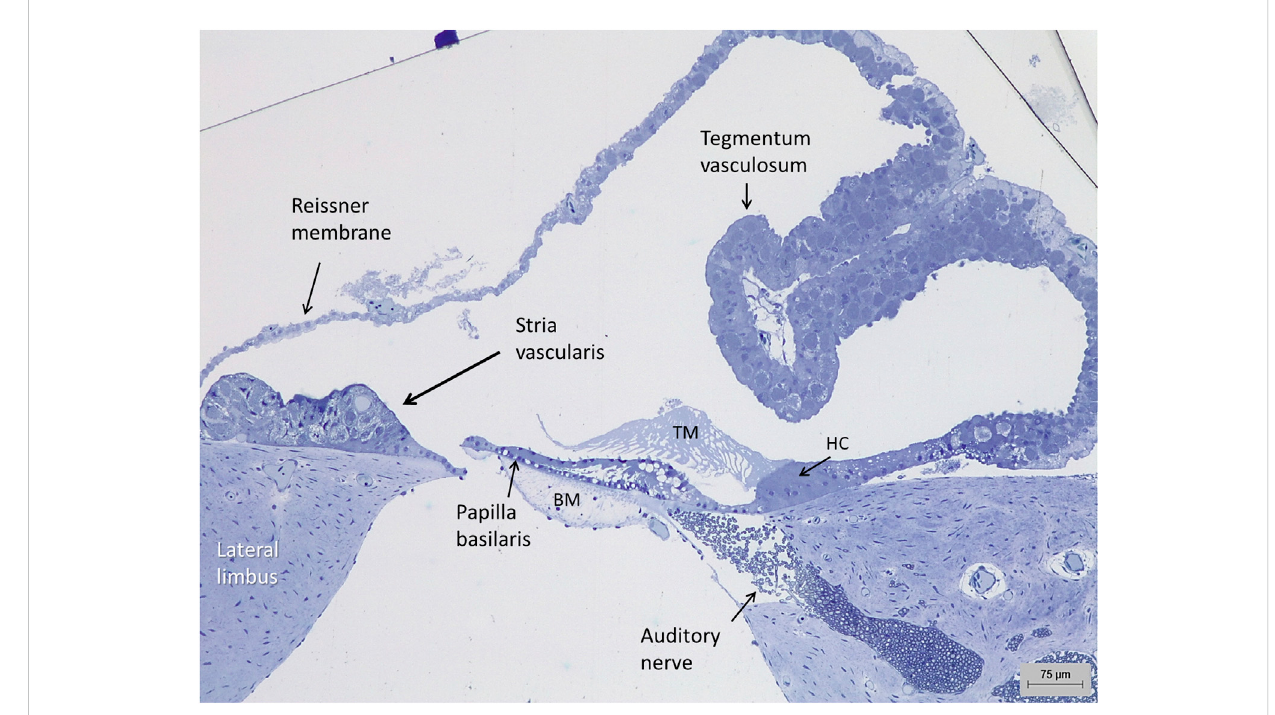
FIGURE 1 Light microscopy of the auditory organ in the Crocodylus rhombifer . A stria vascularis is located at the lateral limbus. A tegmentum vasculosum epithelium evaginates into the endolymphatic space. HC, homogene cells; TM, tectorial membrane; BM, basilar membrane.